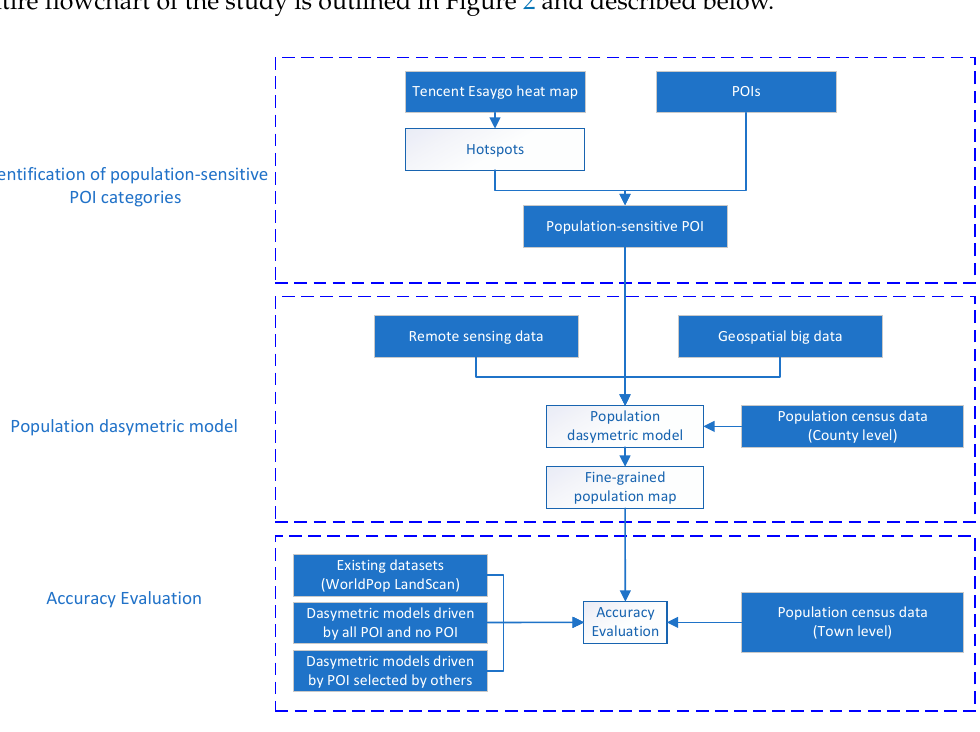
Figure 2. The flowchart for the method in this study.